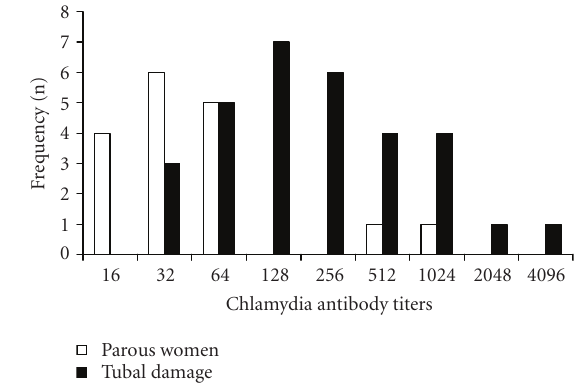
Figure 1: Frequency of C. trachomatis antibody titers in women with tubal damage and in parous